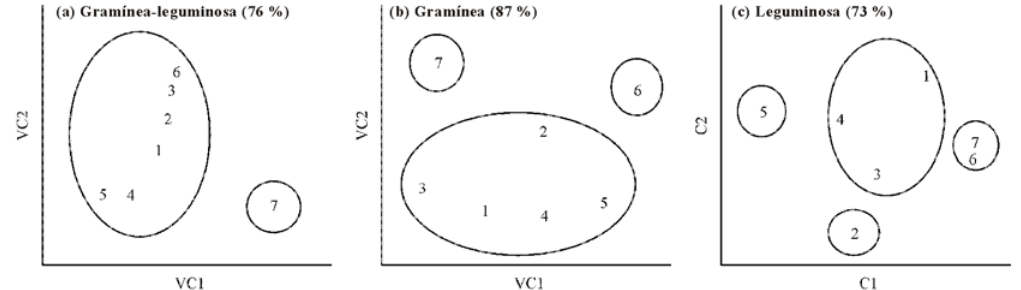
Figura 2. Dispersão dos sete porta-enxertos em relação às duas variáveis canônicas (VC1 e VC2) e aos dois primeiros componentes principais (C1 e C2), agrupados pelo método de Tocher (círculos e elipses), para os teores de nutrientes foliares das laranjeiras ‘Folha Murcha’, em sistemas de manejo da cobertura do solo com gramínea-leguminosa, gramínea e leguminosa. Porta-enxertos: 1 - (limoeiro ‘Cravo’), 2 - (limoeiro ‘Rugoso da África’), 3 - (limoeiro ‘Volcameriano’), 4 - (tangerineira ‘Cleópatra’), 5 - (tangerineira ‘Sunki’), 6 - (citrangeiro ‘C-13’) e 7 - (trifoliata). Os percentuais dentro dos parênteses correspondem aos valores dos dois primeiros